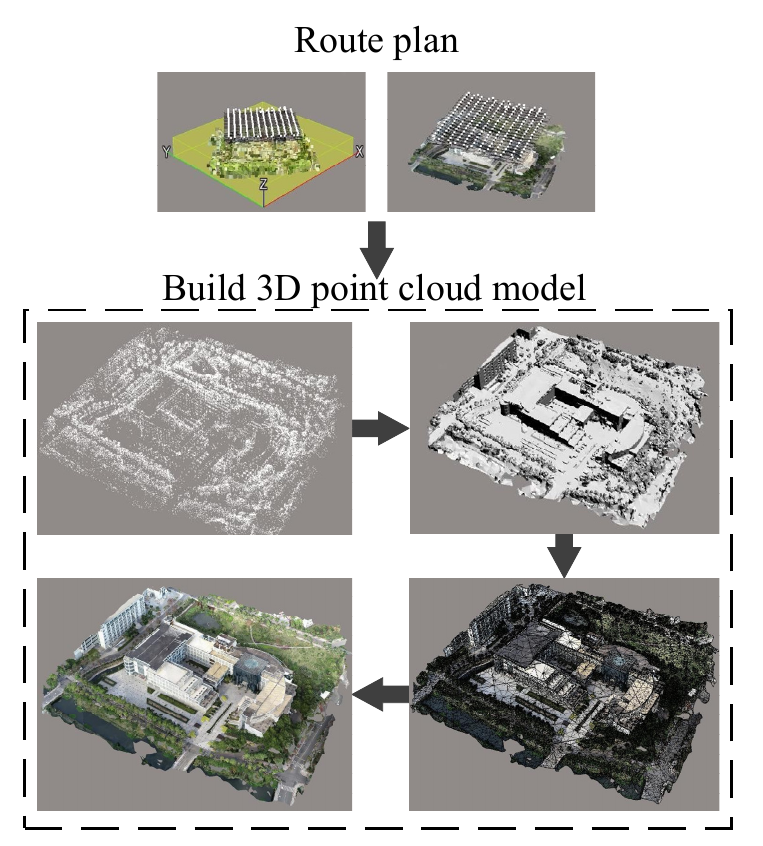
Figure 8. Building process of the library’s 3D point cloud